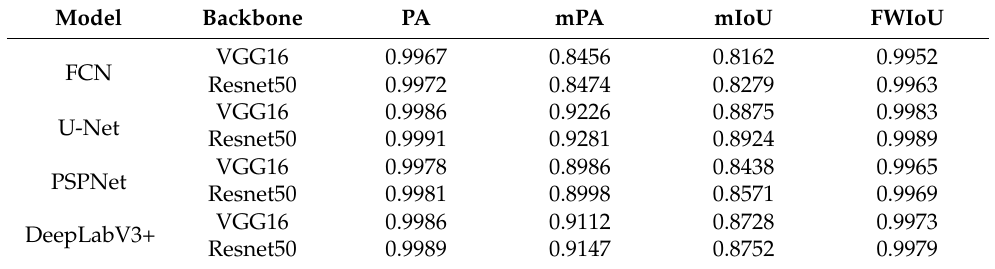
Table 4. Evaluation indicators of models.